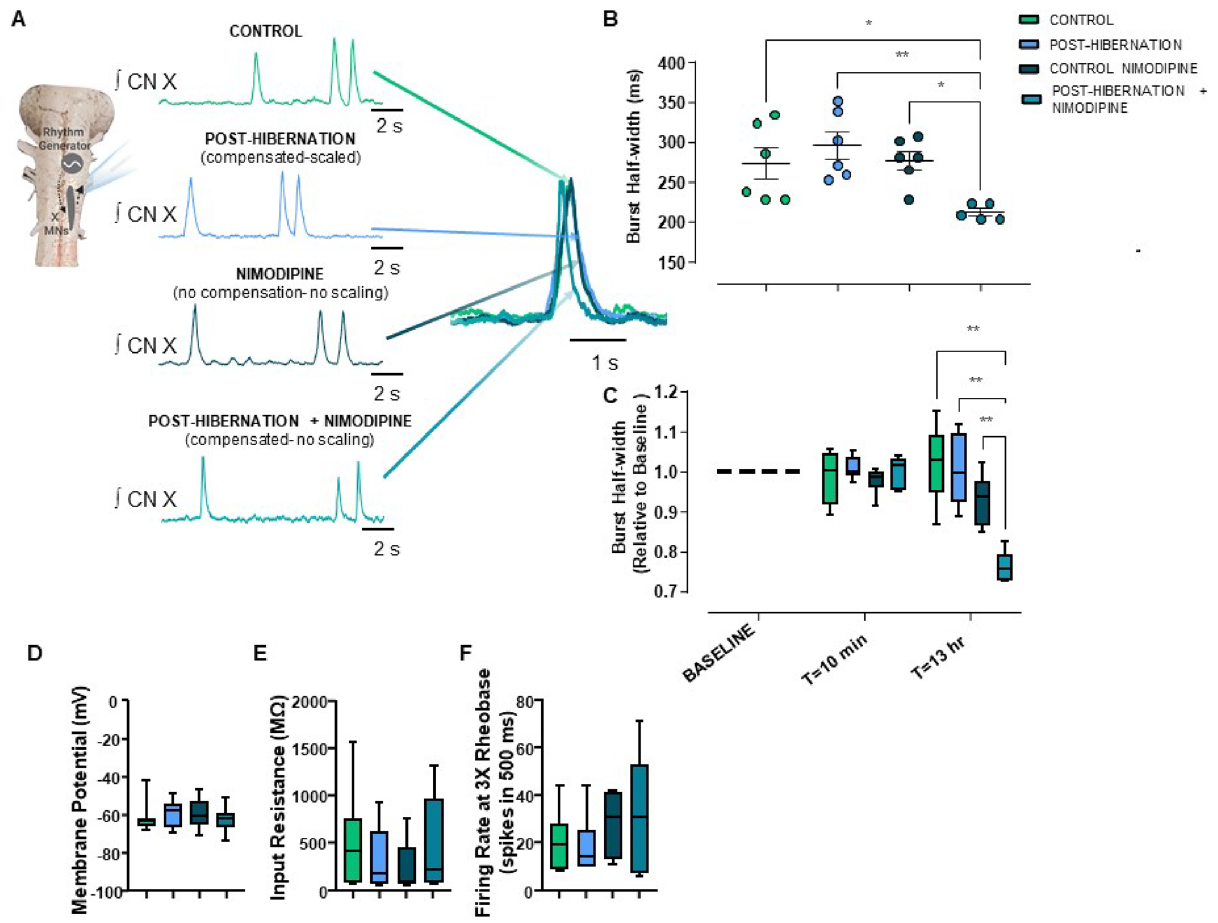
Figure 7. A failure to precisely scale motoneuron synaptic strength is associated with reduced respiratory motor outflow. ( A ) Simplified schematic of the brainstem preparation, highlighting integrated respiratory- related motor output recorded from the vagus nerve. The four groups shown are time control, post-hibernation (associated with scaled compensation), warm-acclimated + nimodipine (no compensation, no scaling), and post-hibernation + nimodipine ("unscaled" compensation) for 13 h in vitro. Traces are compressed or expanded and overlayed to highlight differences across groups. ( B ) Nimodipine applied following hibernation resulted in narrower respiratory bursts from the vagus nerve (One-way ANOVA with Holm-Sidak’s Multiple Comparisons Test; control vs. post-hibernation nimo, p = 0.049, post-hibernation vs. posthibernation nimo, p = 0.007, nimo vs posthibernation nimo = 0.041). ( C ) Nimodipine resulted in a slow reduction of burst width in the post-hibernation group, as acute exposure to nimodipine did not affect burst amplitude in any group (Two-way ANOVA followed by Holm-Sidak’s multiple comparisons tests). However, burst width decreases with longer exposure of nimodipine only after hibernation. Intrinsic membrane properties were not different across groups. Membrane potential ( D , p = 0.356; Kruskal–Wallis test), input resistance ( E , p = 0.409; Kruskal–Wallis test), firing frequency at 3 × rheobase ( F ; p = 0.504; one-way ANOVA). For ( A ), n = 6, 6, 6, and 5 brainstem preparations for control, post-hibernation, nimodipine, and post-hibernation nimodipine, respectively. For ( D , E ), n = 20, 17, 20, and 19 neurons for control, post-hibernation, nimodipine, and post- hibernation + nimodpine, respectively. For assessment of firing rate ( F ), n = 7, 6, 6, 7 neurons were used in control, post-hibernation, nimodipine, and post-hibernation + nimodpine, respectively. Box and whisker plots show the interquartile range. Whiskers extend to maximum and minimum values *p < 0.05, **p <